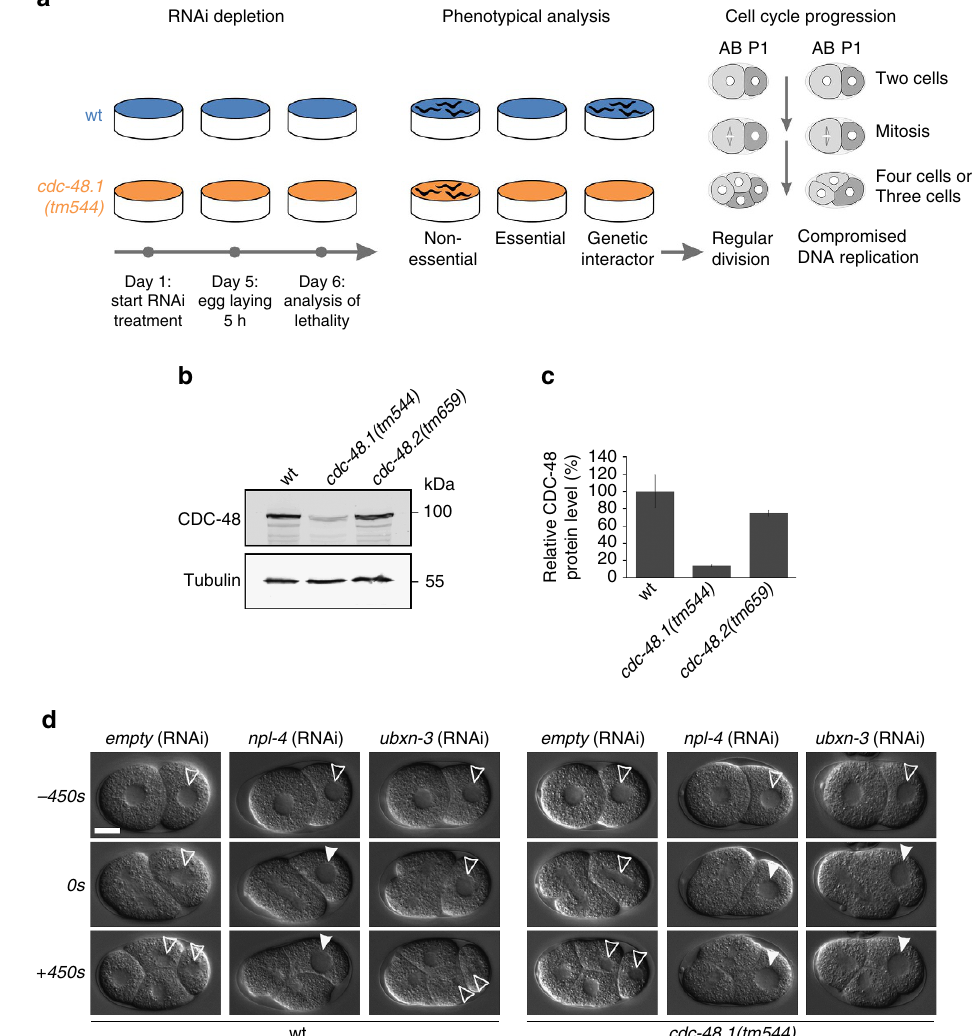
Figure 1 | Worms lacking CDC-48.1 are sensitized for ubxn-3 depletion. ( a ) Schematic illustration of the RNAi screening procedure to identify genetic interactors of cdc-48.1 . Wild-type (wt) worms (blue) and cdc-48.1(tm544) deletion mutants (orange) were depleted for candidate genes by RNAi before analysis of embryonic lethality or developmental growth defects (indicated by an empty plate). Potential interactor genes were analysed for cell division defects by time-lapse microscopy. ( b , c ) Western blot analysis of CDC-48 and tubulin protein levels in embryonic extracts of wt, cdc-48.1 or cdc-48.2 deletion mutants. Graph shows CDC-48 level relative to tubulin. Error bars show s.d. of mean values generated in five independent experiments. ( d ) Selected pictures of time-lapse recordings of wt or cdc-48.1(tm544) embryos depleted for indicated genes by RNAi. To visualize a prolonged three-cell stage, embryonic division is shown at onset of mitosis in the AB cell (0s) and respective time points before or thereafter ( ± 450s). Empty arrowheads indicate wild-type-like division pattern; filled arrowheads indicate delayed cell division of the P1 cell. Scale bar, 10 m